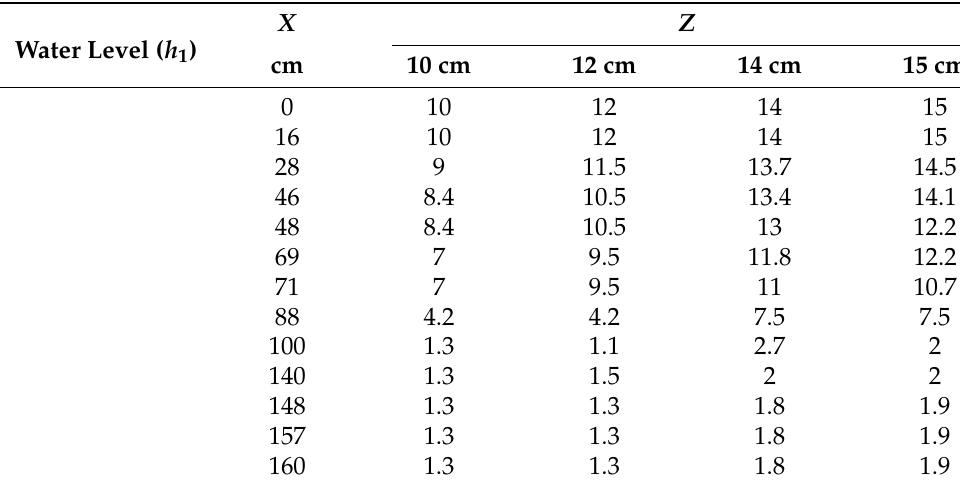
Table 1. Free-surface observations as in [10] and the x positions used in this